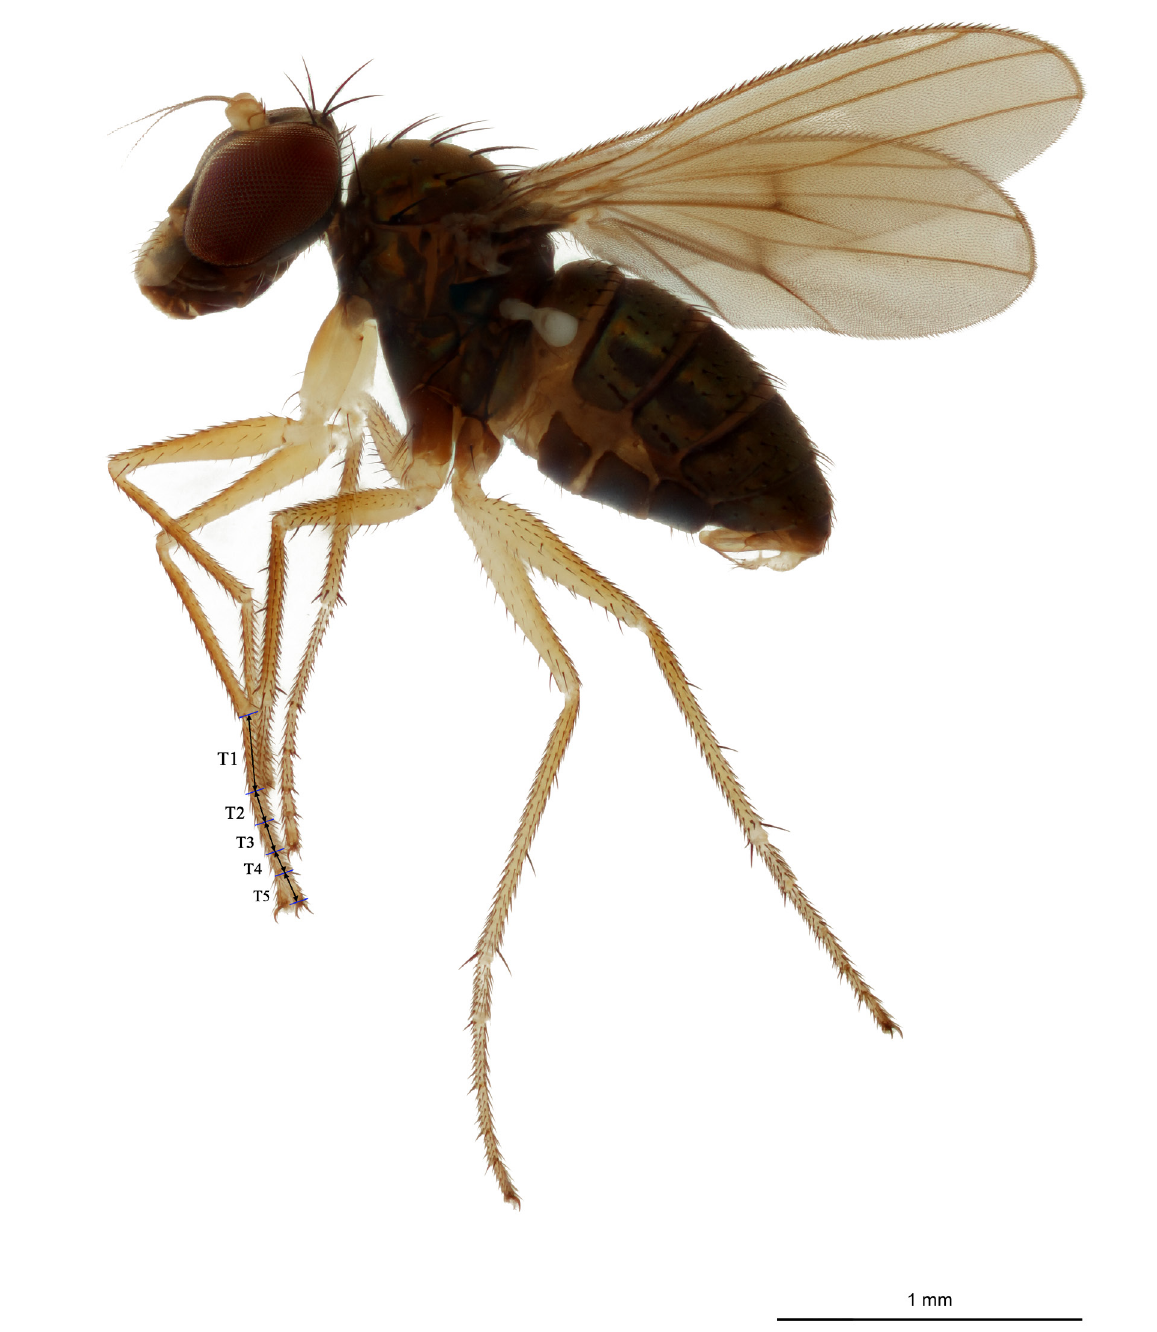
Fig. 12. Thinophilus minutus sp. nov., ♂,